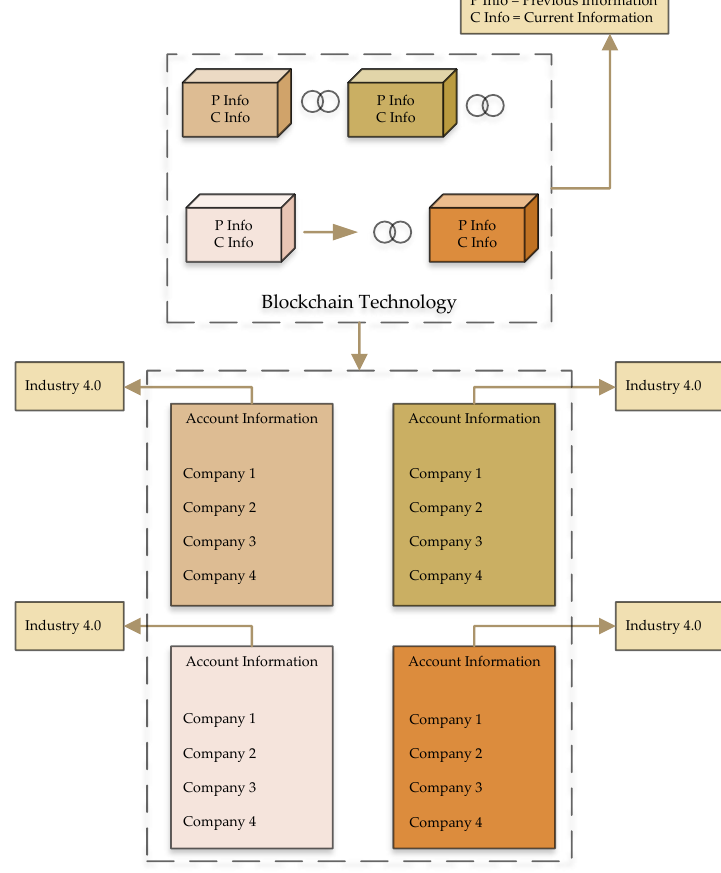
Figure 3. Overview of exchange rate based on the blockchain